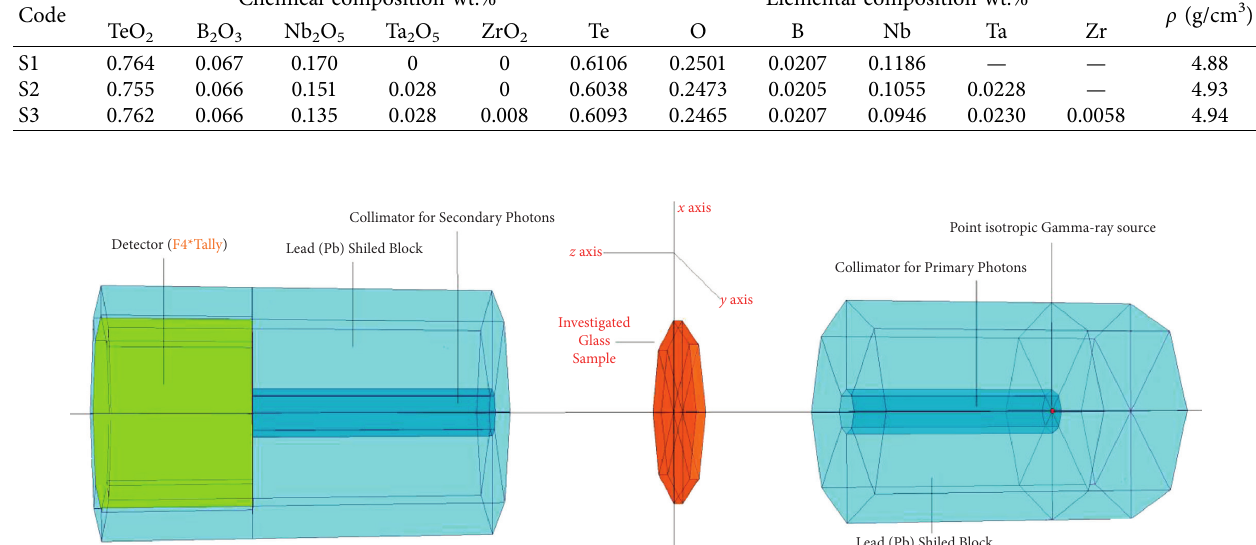
Table 1: Code, chemical composition, elemental composition, and density ( ρ ) of the prepared glasses. Chemical composition wt.% Elemental composition wt.% Code